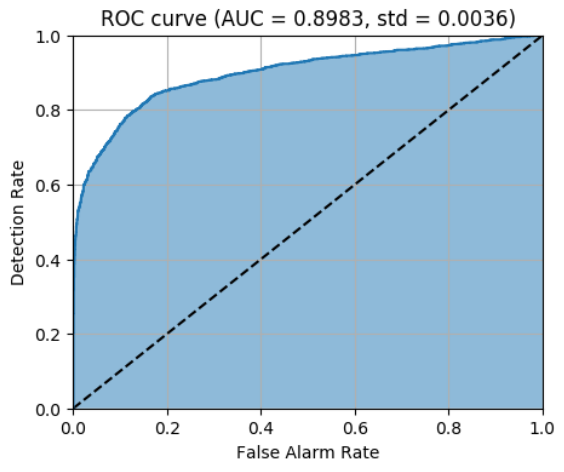
Figure 9. One example of the ten receiver operation characteristic (ROC) curves with average AUC = 0.8983 and its standard deviation = 0.0036. AUC: area under ROC